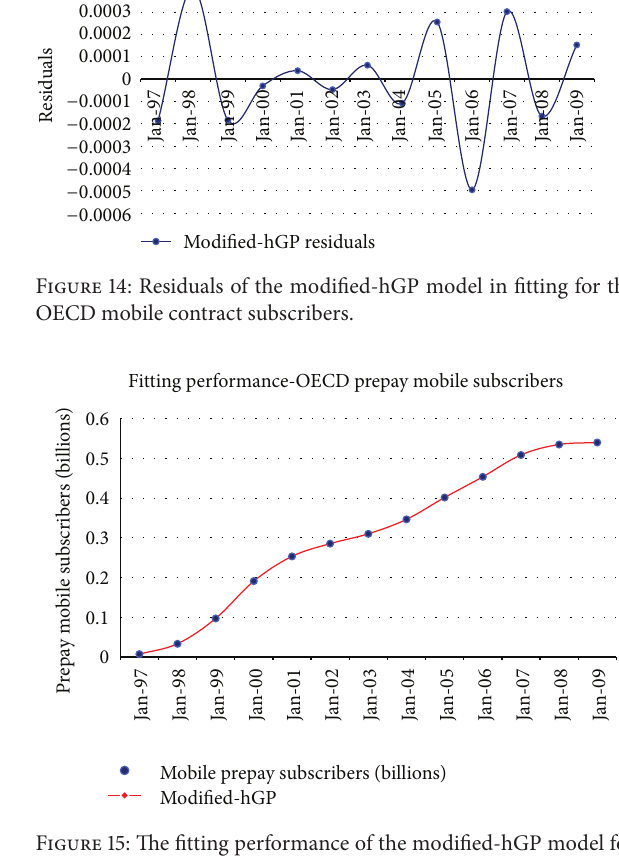
Figure 15: The fitting performance of the modified-hGP model for the OECD mobile prepay